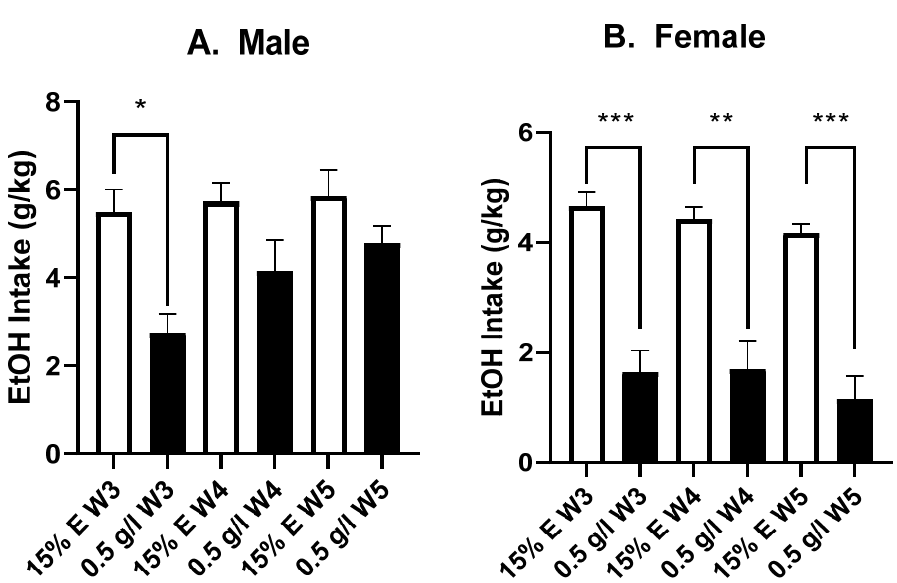
Figure 4. Quinine resistance to higher quinine (0.5 g/L) after 3–5 weeks EtOH drinking. ( A ) In male P-rats ( n = 12) , EtOH drinking was sensitive to 0.5 g/L quinine after 3 weeks intake (W3) (* p < 0.05). However, after 4 weeks (W4) or 5 weeks (W5) of EtOH drinking, male intake persisted despite 0.5 g/L quinine in EtOH. ( B ) In contrast to males, female ( n = 12) EtOH drinking was significantly reduced by 0.5 g/L quinine at W3 (*** p < 0.001), W4 (** p < 0.01), and W5 (*** p < 0.001).